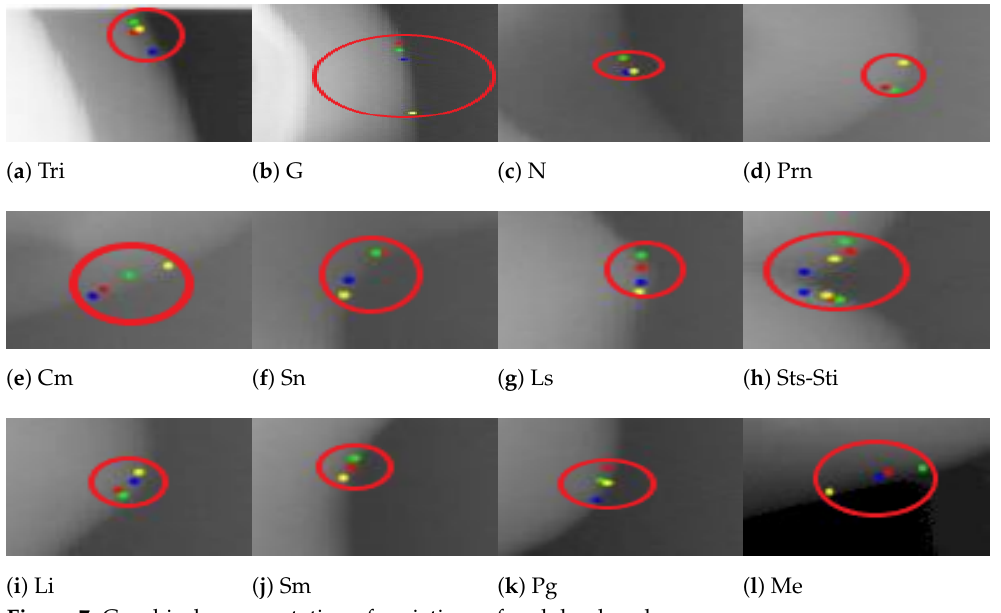
Figure 7. Graphical representation of variations of each